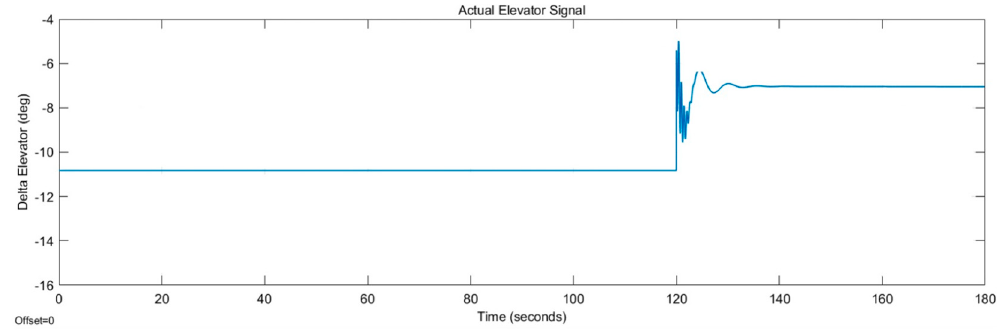
Figure 18. Actual elevator signal with 50% LOE fault in a closed-loop system.